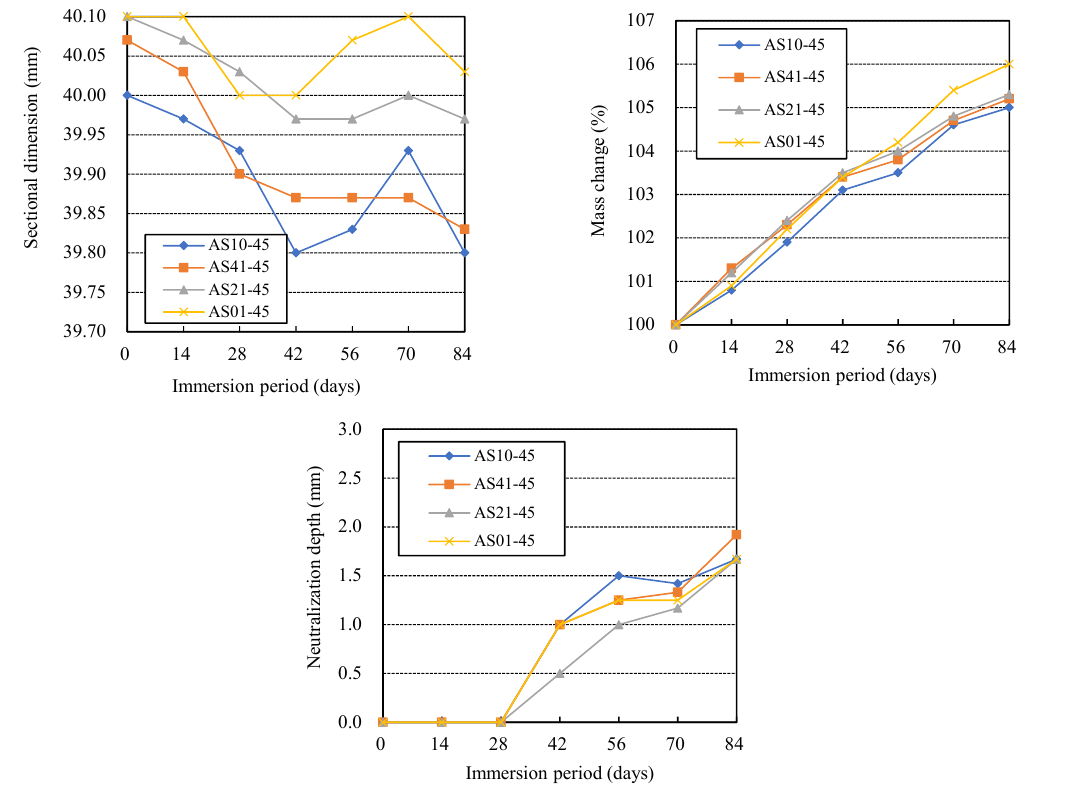
Figure 6. Effects of alkali activation solution’s components on the acid resistance of AAFS.